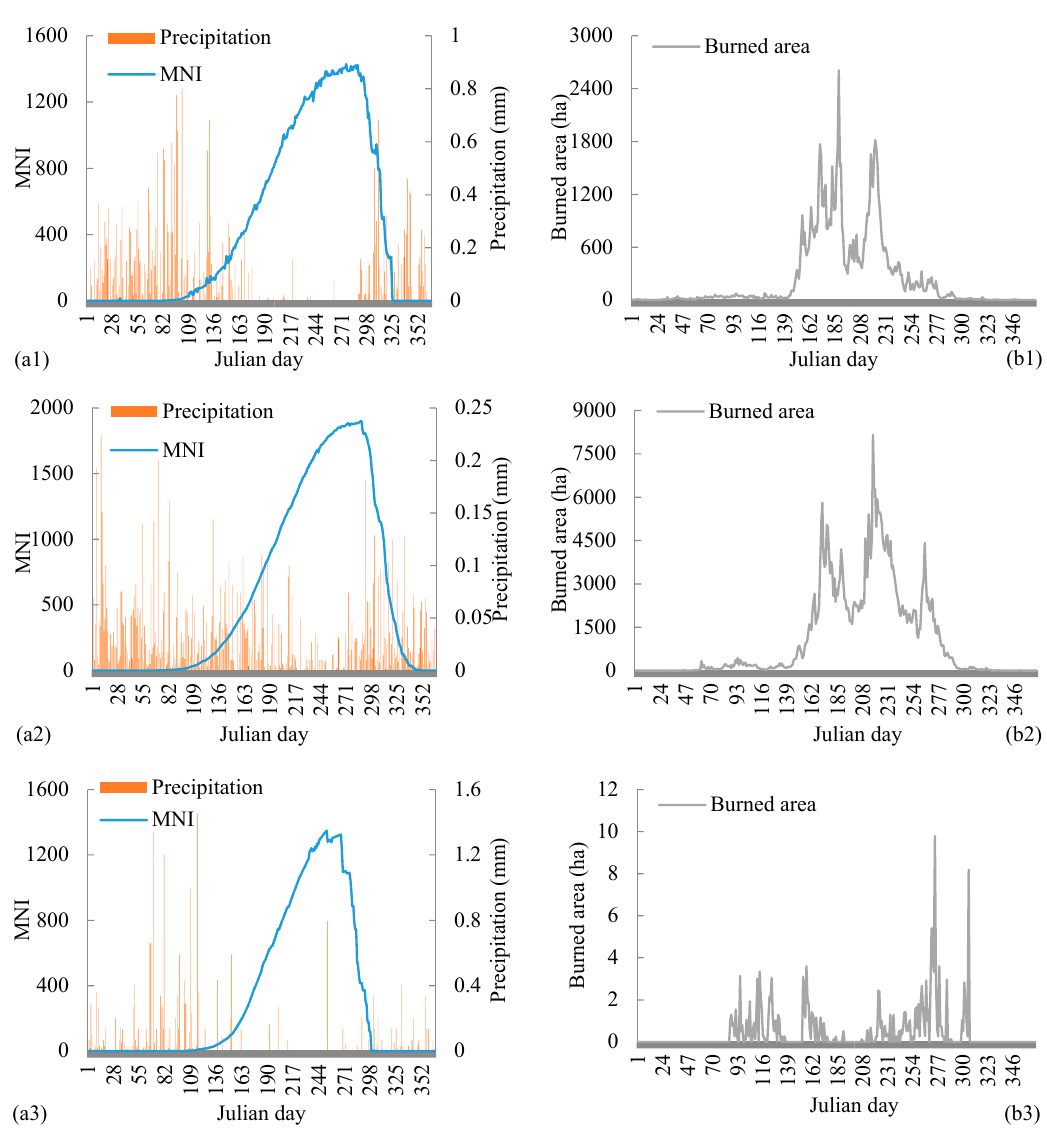
Figure 4. MNI distribution in three vegetation zones for the 2001–2015 period. 3.2. Distribution of Burned Areas in the 2001–2015 Period The mean annual burned area was 87,812 ha in R1 during the 2001–2015 period. The burned areas in 2002, 2004, and 2005 were significantly higher than the average of the period ( α = 0.05), and the burned areas were significantly lower in 2001, 2003, 2011, 2012, and 2013 (Figure 5a1). The monthly maximum burned areas occurred in May, with 26,603 ha, and the minimum occurred in November, with 250 ha (Figure 5b1). The mean annual burned area in R2 was 389,020 ha, which was much higher than that in the other zones. The maximum monthly burned area was 133,452 ha in August, and the minimum was 1211 ha in November. The mean annual burned area in R3 was 150 ha. The months in the fire season with the maximum and minimum burned areas were September and June, respectively (Figure 5b3). The monthly burned areas and MNI in the fire season for R1 and R3 did not show a strong correlation ( r = 0.36), but they showed a strong correlation for R2 ( r = 0.6) as follows: B ( n ) = 2.4683 MNI ( n ) + 13 , 101 ( R 2 = 0.32)